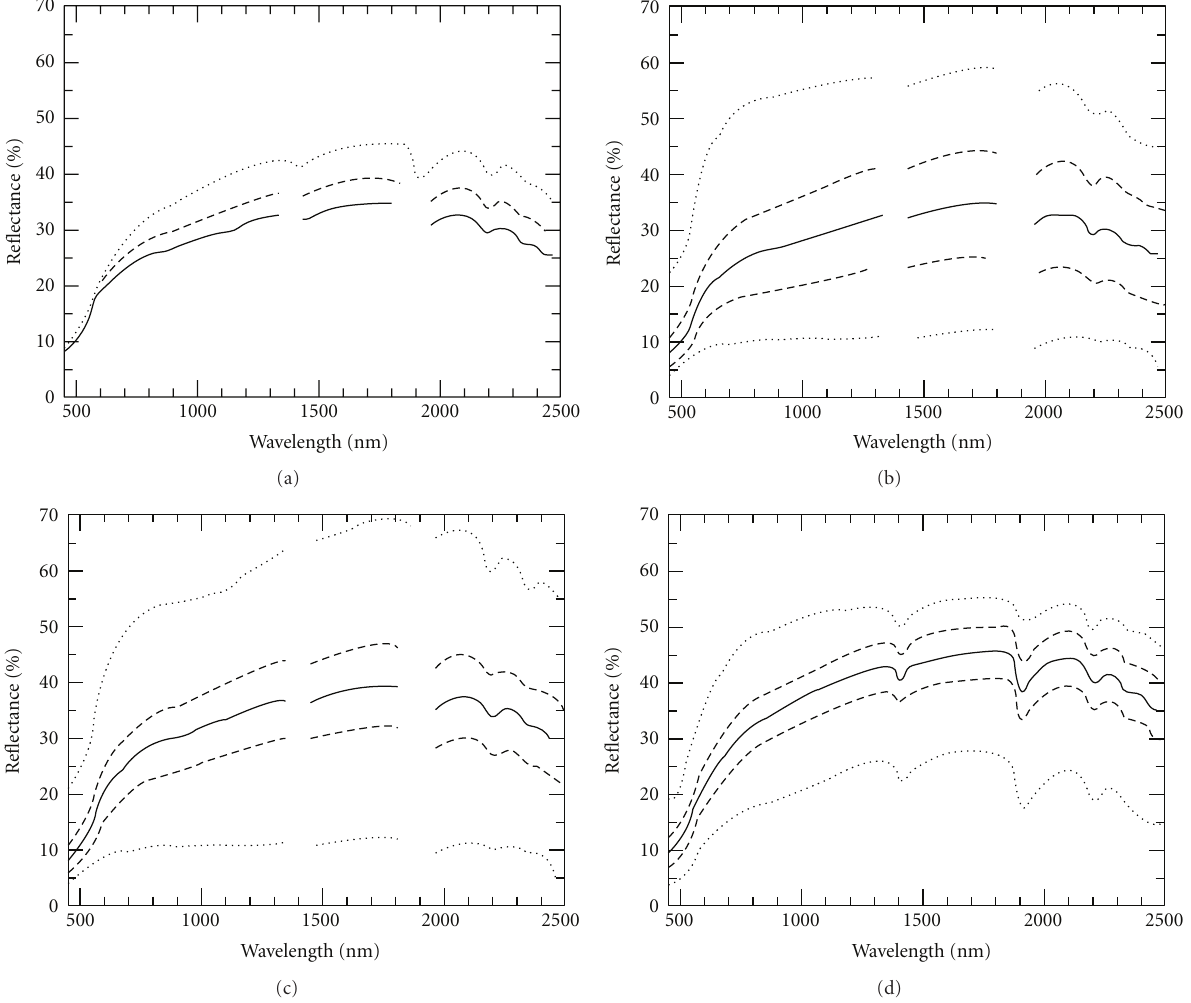
Figure 4: Comparison of mean spectra of the three spectral libraries (a) of insitu field (solid), field bare soil (dashed), and laboratory measurements (dotted). Statistical overview of 125 insitu field soil measurements (b), 125 field bare soil (c), and 163 laboratory spectra (d) with mean (solid), positive and negative standard deviation (dashed), minimum and maximum (dotted). All spectra are given in full ASD spectral